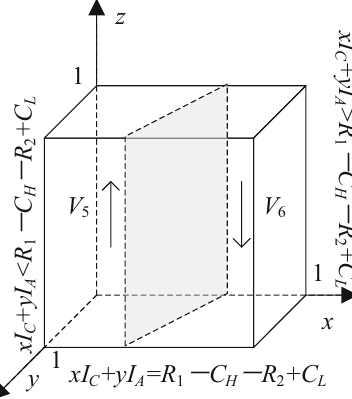
Fig. 4 Dynamic trend diagram for the logistics